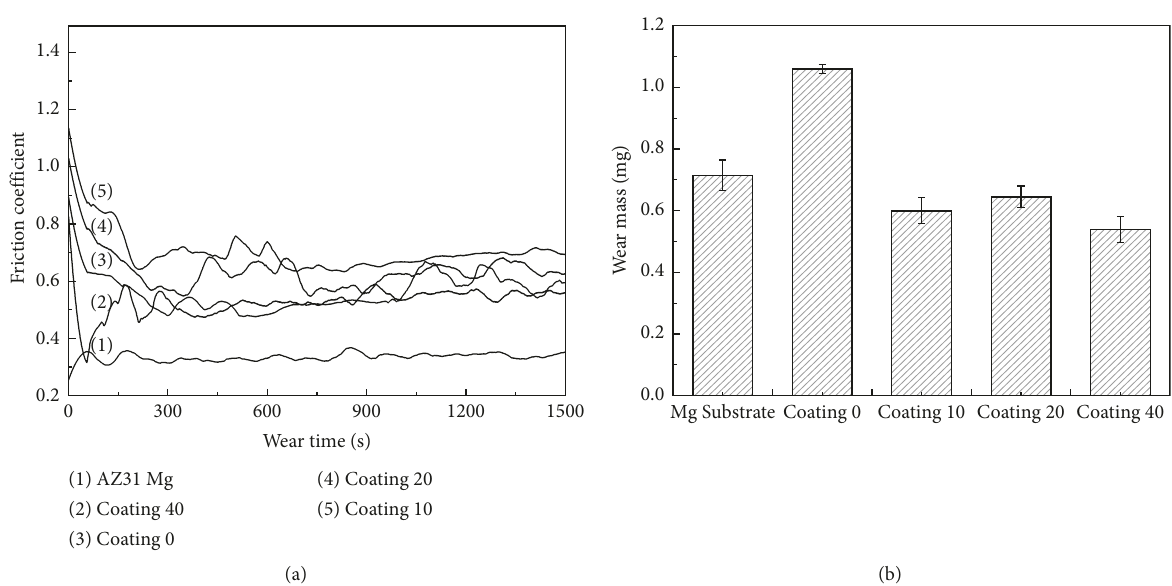
Figure 4: Friction coefficient (a) and wear mass (b) of the substrate and the coatings.